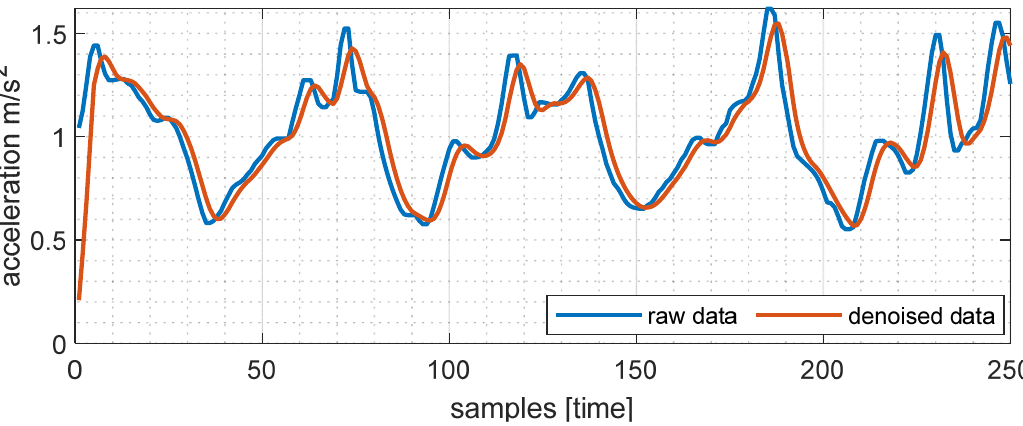
Figure 2. Signal denoising for the wearable inertial signals in the proposed HPAR framework .